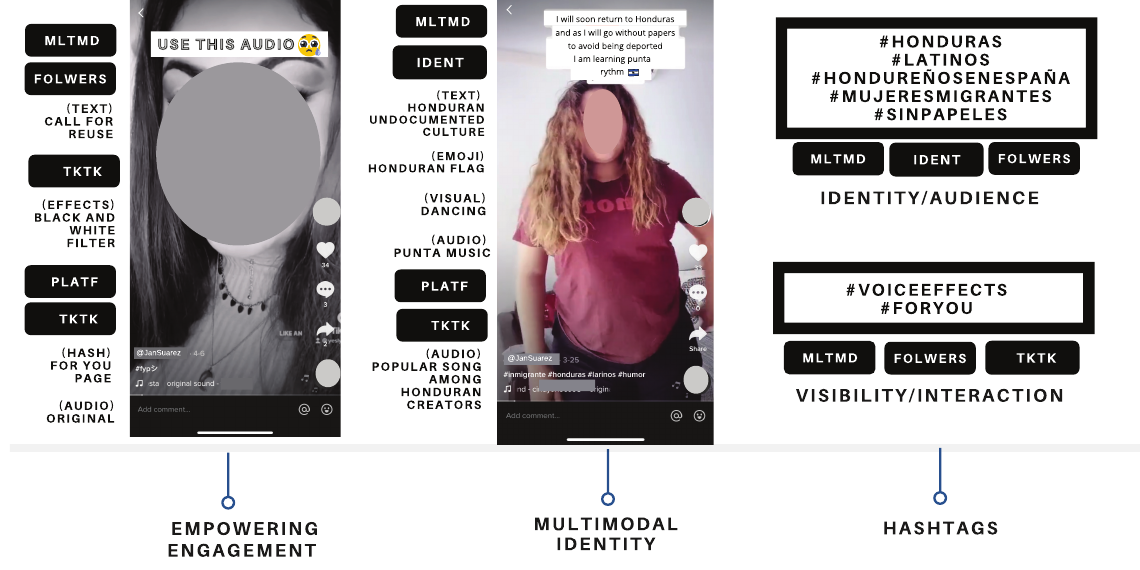
Figure 7. JanSuarez’s multimodal and visibility